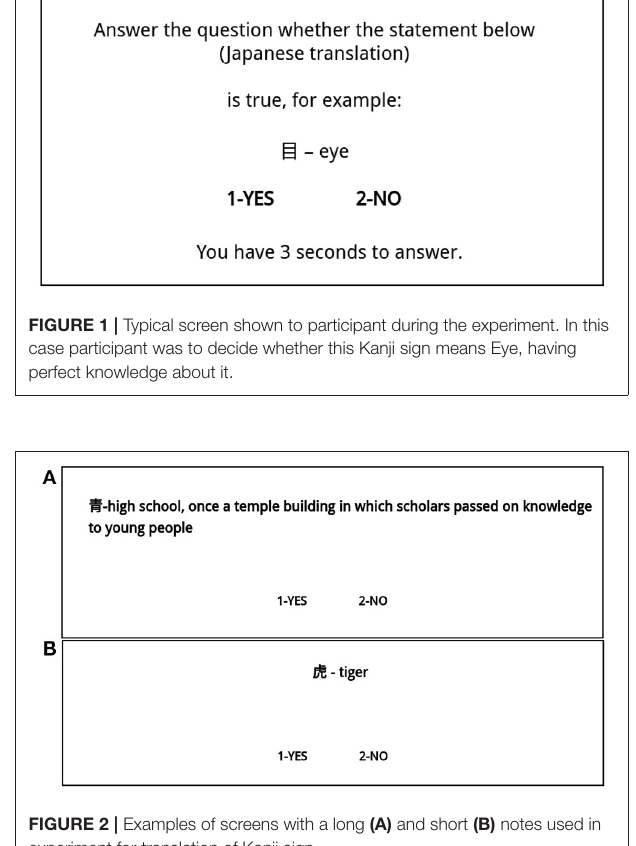
the single-word Kanji sign translations as “short note,” and to the longer translations as “long